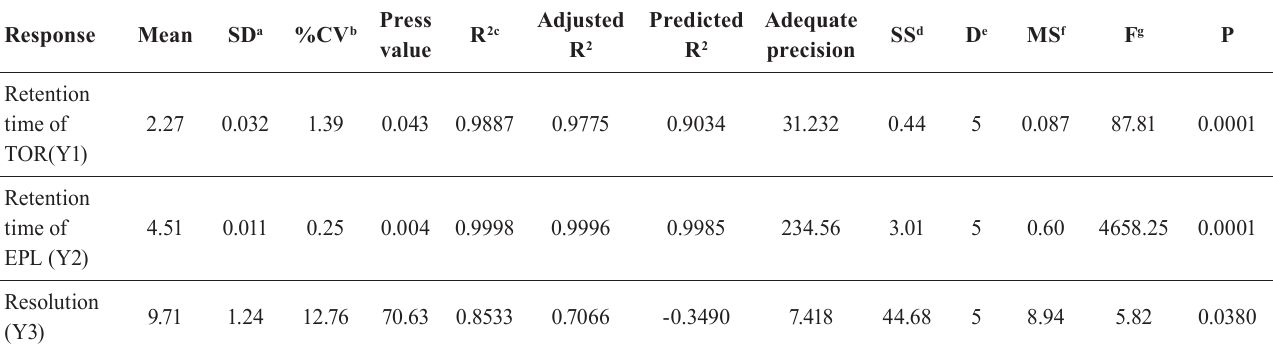
TABLE IV - ANOVA regression analysis for models and responses